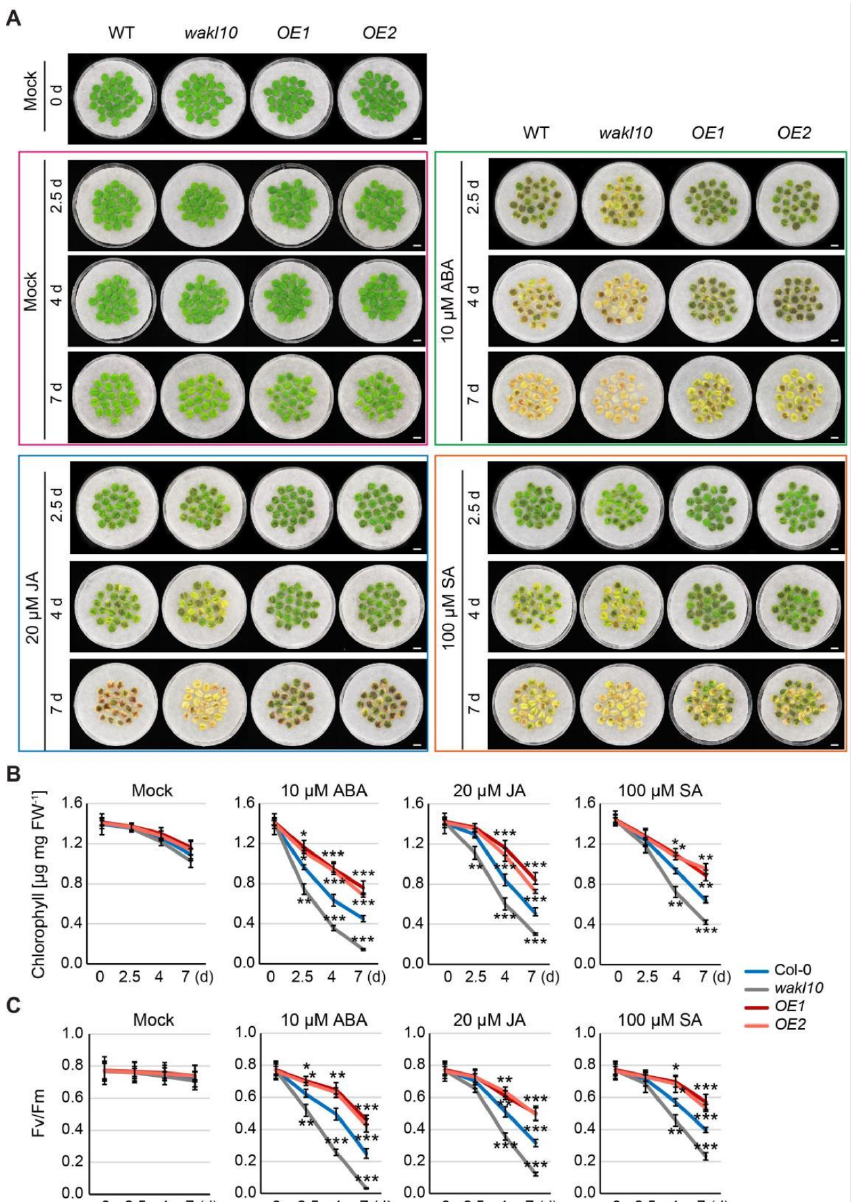
indicated that AtWAKL10 had an inhibitory effect on natural senescence as well as ABA-, JA-, and SA-induced leaf senescence.